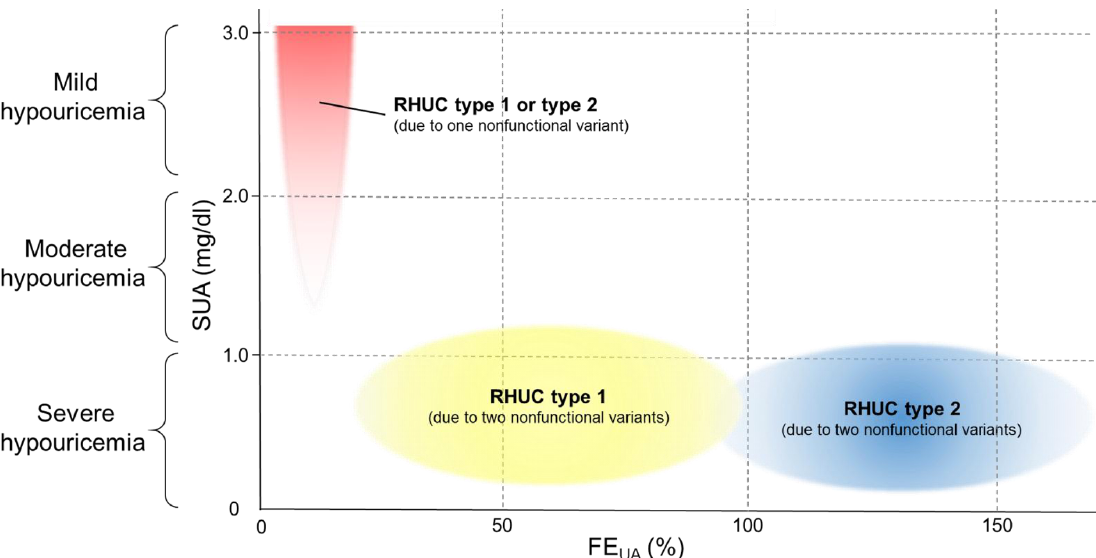
Figure 4. Specific distribution patterns of FE UA and SUA of RHUC type 1 and 2 with the number of nonfunctional variants. This figure shows the relationship between RHUC and the number of nonfunctional variants of URAT1 or GLUT9 based on the patterns of FE UA and SUA data. The horizontal and vertical axes respectively show FE UA and SUA. Hypouricemic individuals (SUA ≤ 3.0 mg /dL ) were divided into the following three groups: “severe hypouricemia” (SUA of ≤ 1.0 mg /dL), “moderate hypouricemia” (SUA of 1.1 – 2.0 mg/dL ) and “mild hypouricemia” (SUA of 2.1 – 3.0 mg/dL). Typical laboratory data (FE UA and SUA) for RHUC type 1 or 2 patients are shown in the following three patterns: The yellow and blue areas show “RHUC type 1 due to two nonfunctional variants of URAT1 ” (see also Figure 3h) and “RHUC type 2 due to two nonfunctional variants of GLUT9 ” (see also Figure 3i), respectively. The red area shows “RHUC type 1 due to one non- functional variant of URAT1 (see also Figure 3q)” or “RHUC type 2 due to one nonfunctional variant of GLUT9 (see also Figure 3r)”. Data from RHUC patients with other diseases, including renal dysfunction, might land in different areas from these three patterns. RHUC, renal hypouricemia; SUA, serum uric acid; FE UA , fractional excretion of uric acid.